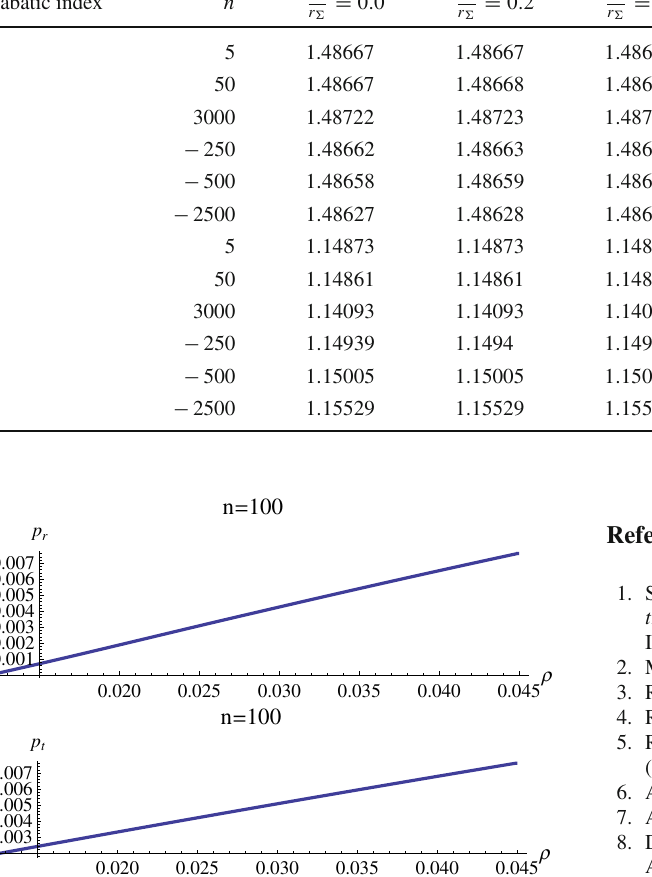
Table 4 The numerical values of (cid:15) r and (cid:15) t are obtained by fixing b = 0 . 0095 for a compact star of mass M = 1 . 85 M (cid:3) and radius = 9 . 5 km. for different values of n Adiabatic index